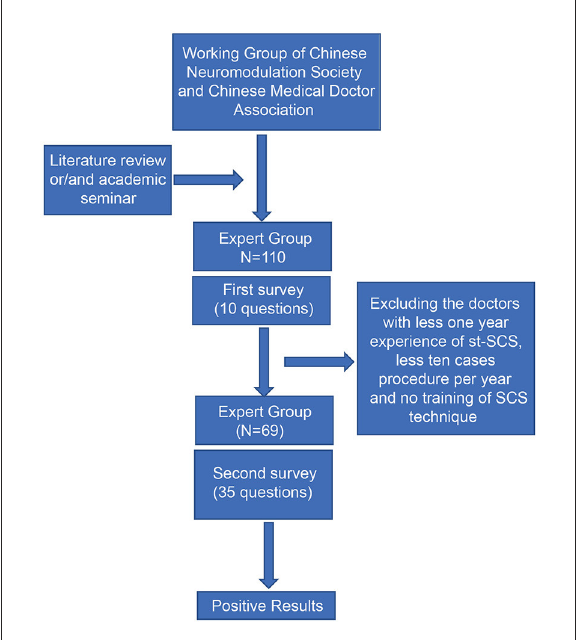
FIGURE1 Schematic diagram of the consensus